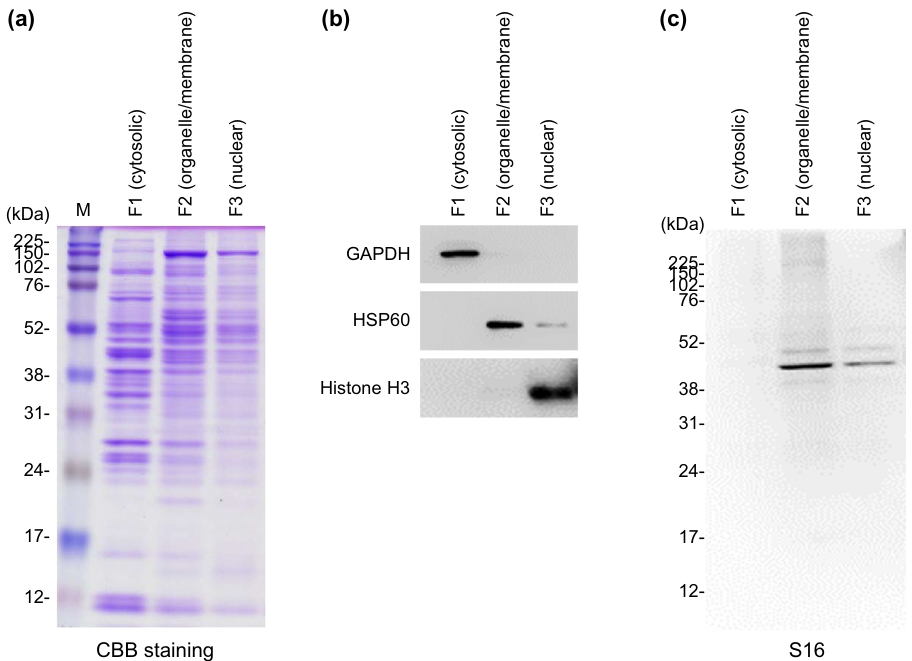
Figure 3. Subcellular localization of S16-binding protein in liver. Homogenized livers of BALB/c mice (7-week-old, female, n = 3) were fractionated into the cytosolic (F1), organelle/membrane (F2), and nuclear (F3) fractions. Proteins (3 μg) were separated on a 12% SDS-PAGE with reference molecular weight markers (M). Gels were subjected to CBB staining ( a ) or western blotting using α-mouse GAPDH mAb, α-mouse HSP60 mAb, α-mouse histone H3 mAb ( b ), or S16 ( c ). Molecular weight markers are shown at the left of the gels (kDa). Images shown are the representative results of three independent experiments.